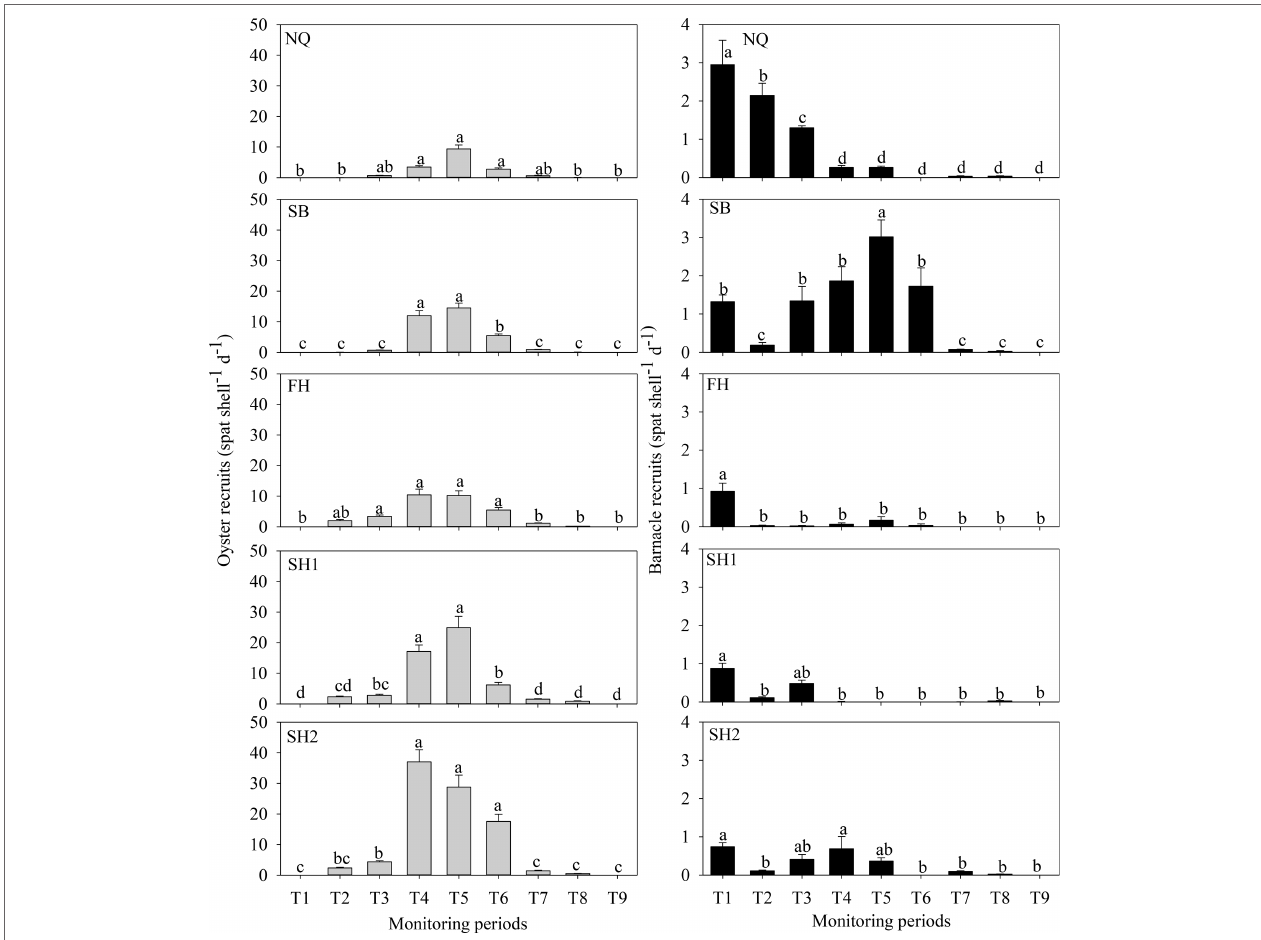
FIGURE 5 | Spatial and temporal variations in the oyster (left panel) and the barnacle (right panel) recruitment (mean ± SE) in the spawning season of 2020. Significant differences were indicated by different lowercase letters ( p <